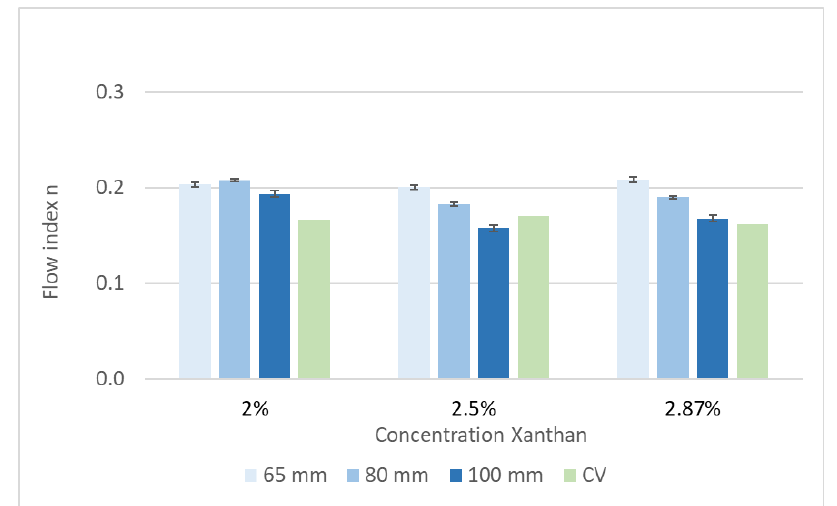
Figure 5. Xanthan solution: flow index n, measured with a pipe viscometer with di ff erent diameters and with a capillary viscometer (CV).